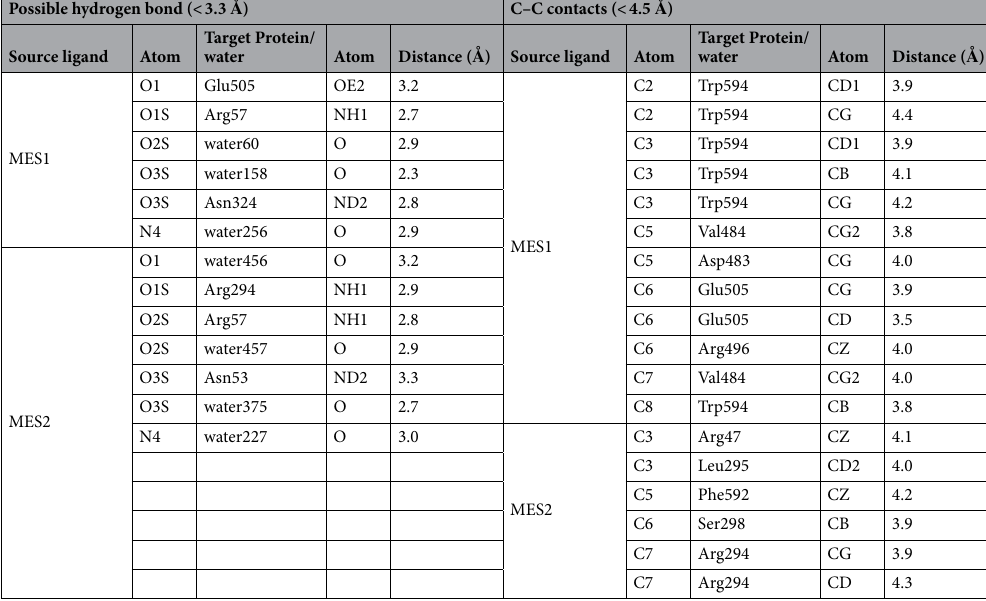
Possible hydrogen bond (< 3.3 Å